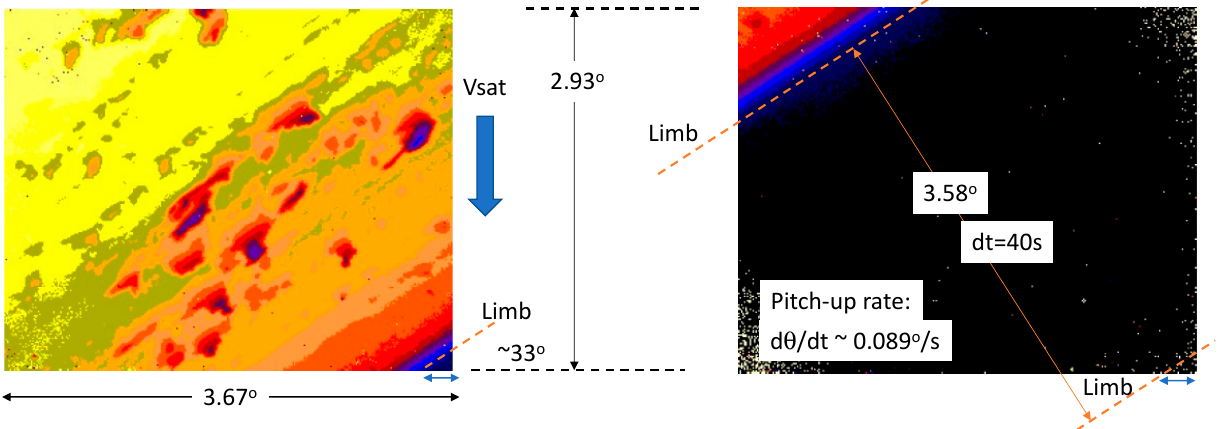
Figure 7. Two CTI frames, separated by 40 s in time during the pitch-up operation, in which the Earth limb is seen moving across the CTI images. From the consecutive CTI images with the limb in the field of view, the pitch-up rate could be derived and was found to be ~0.089°/s in this case. In this pitch-up scan, the Earth’s surface was ~33° with respect to the detector row. The satellite velocity (Vsat) is indicated by the thick arrow.